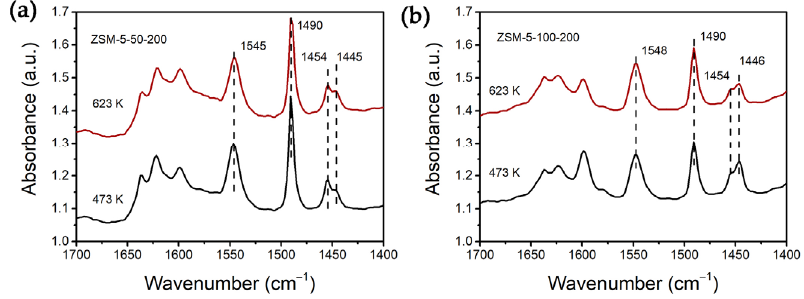
Figure 13. Py ‐ IR profile of ZSM ‐ 5 ‐ 50 ‐ 200 ( a ) and ZSM ‐ 5 ‐ 100 ‐ 200 ( b ). Figure 13. Py-IR profile of ZSM-5-50-200 ( a ) and ZSM-5-100-200 ( b ). In order to reveal the crystallization mechanism, ZSM ‐ 5 ‐ 100 ‐ 200 with different crys ‐ Table 2. Py-IR measurements of acidity for ZSM-5-50-200 and ZSM-100-200. tallization times was detected by ex situ photographs, XRD and SEM to monitor the crys ‐ tallization process (Figures 14 and 15). In the early stage, a clear, colorless and transparent heterogeneous liquid mixture was formed in the biphasic medium, as shown by digital photographs. An obvious stratification appeared after standing for 0.5 min. Then, the un ‐ derlying aqueous phase became milky white after dynamic crystallization for 2 h, mainly because the crystal sunk into the aqueous phase under the action of gravity. The solid product was found to have good oil solubility in the process of centrifugation, indicating